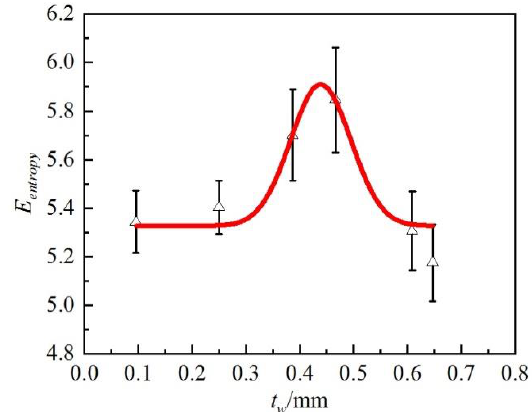
Figure 6. Relationship between information entropy value and corrosion depth.